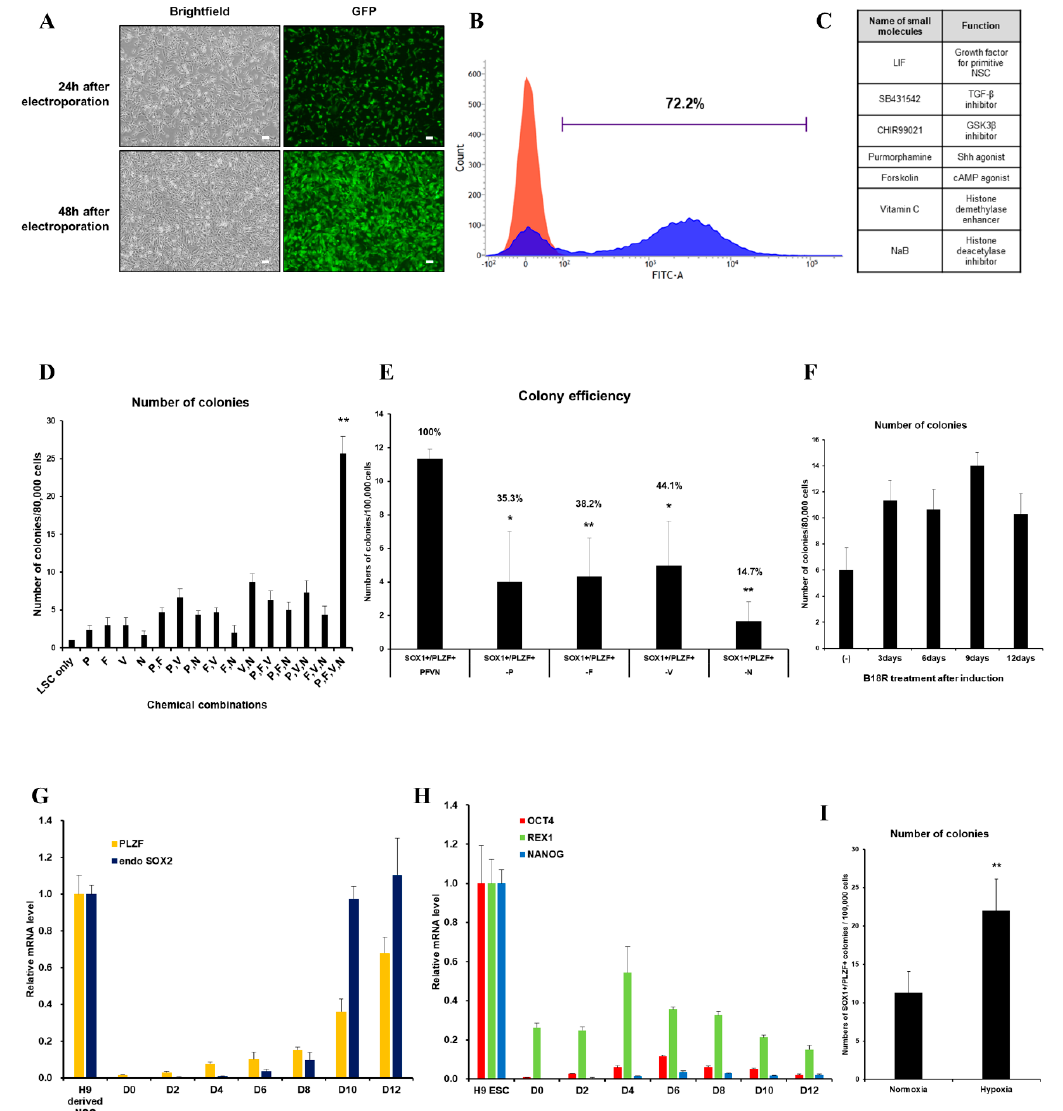
Figure 1. Optimized-conditioning by small molecules for generating induced neural stem cells (iNSCs) from human urine-derived cells (HUCs). ( A ) GFP (Green fluorescence protein) expression in HUCs at 24 and 48 h after electroporation. ( B ) FACS (Fluorescence-activated cell sorting) analysis showed high transfection efficiency to HUCs using synthetic mRNA encoding GFP. ( C ) Small molecules for generating iNSCs from HUCs. ( D ) Treatment with combinations of small molecules (P: purmorphamine, F: forskolin, V: ascorbic acid, N: sodium butyrate) increases efficiency for generating iNSC colonies. ( E ) Exclusion of a small molecule decreases the efficiency for generating iNSC colonies. ( F ) Efficiency for generating iNSC with or without B18R protein during induction. ( G ) qRT-PCR analysis of PLZF and endogenous SOX2 expression during iNSC generation. ( H ) qRT-PCR analysis of OCT4, REX1, and NANOG expression during iNSC generation. ( I ) Hypoxic condition increases the efficiency for generating iNSC colonies. Error bars represent standard deviation. * p ≤ 0.05; ** p ≤ 0.01.